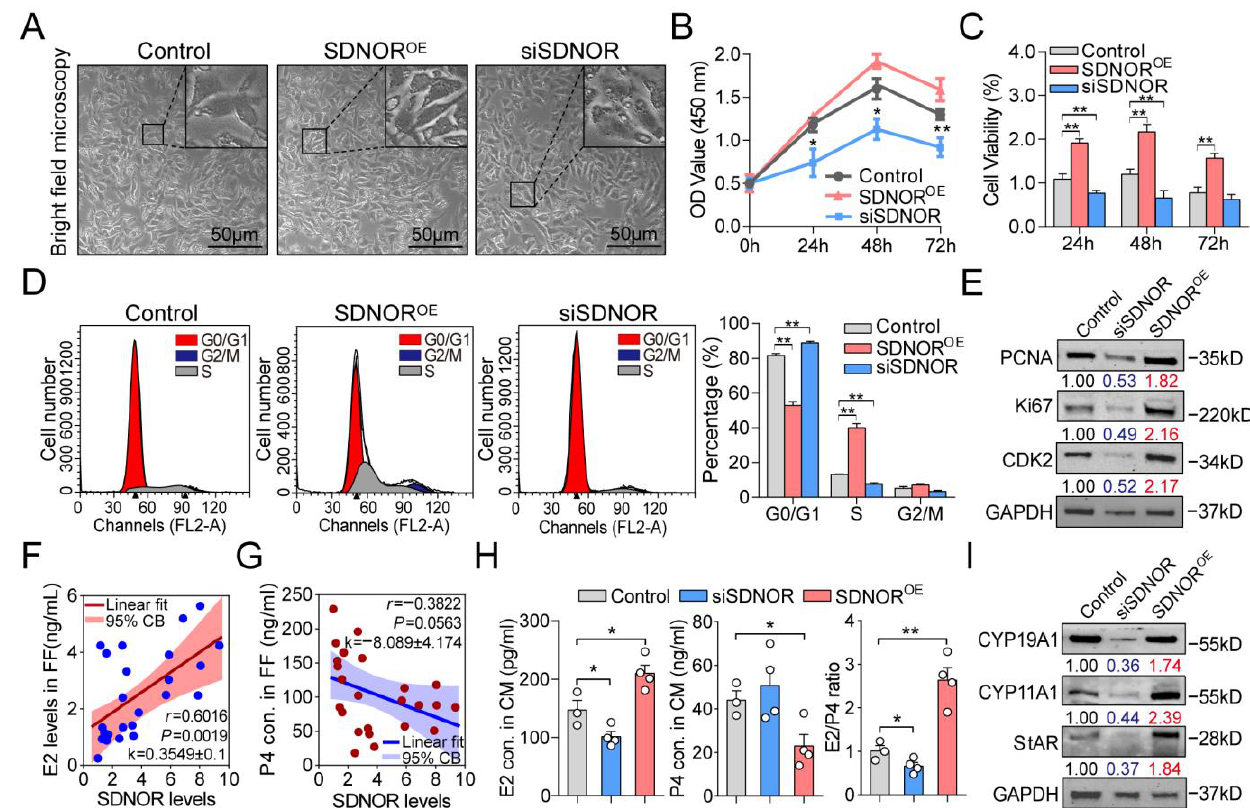
Figure 6. SDNOR is essential for the normal state and function of GCs. ( A ) The morphological features of GCs after knockdown or overexpression of SDNOR were detected by morphometric analyses. ( B ) The effects of SDNOR on the proliferation of GCs were detected by CCK-8. ( C ) The viability of GCs under different conditions for 48 h was detected. ( D ) The effects of SDNOR on the cell cycle were analyzed by FACS. ( E ) The protein levels of PCNA, Ki67, and CDK2 in GCs after knockdown or overexpression of SDNOR were detected by Western blot. ( F , G ) The relationships between SDNOR levels and E2 level ( F ) and P4 level ( G ) in follicular fluid (FF) were detected with Pearson correlation and linear regression analysis ( n = 24). Pearson’s r , p value, slope (k), linear fits, and 95% confidential bands (CBs) are shown. ( H ) After treatment with siSDNOR or SDNOR OE for 48 h, E2 and P4 levels in GC culture medium (CM) were detected by ELISA, and E2/P4 index was calculated. ( I ) The protein levels of CYP11A1, CYP19A1, and StAR in GCs after knockdown or overexpression of SDNOR were detected by Western blot. Data in B – D and H are shown as mean ± S.E.M. with at least three independent replicates. Significance between experimental and control groups in B – E and H , I were analyzed with a two- tailed Student’s t -test. For Western blot assays in E and I , the corresponding normalized fold change values are listed at the bottom of blot images, and significance between experimental and control groups is shown in different colors. Red and blue indicate significantly up- and downregulated, respectively. * p < 0.05, ** p < 0.01.